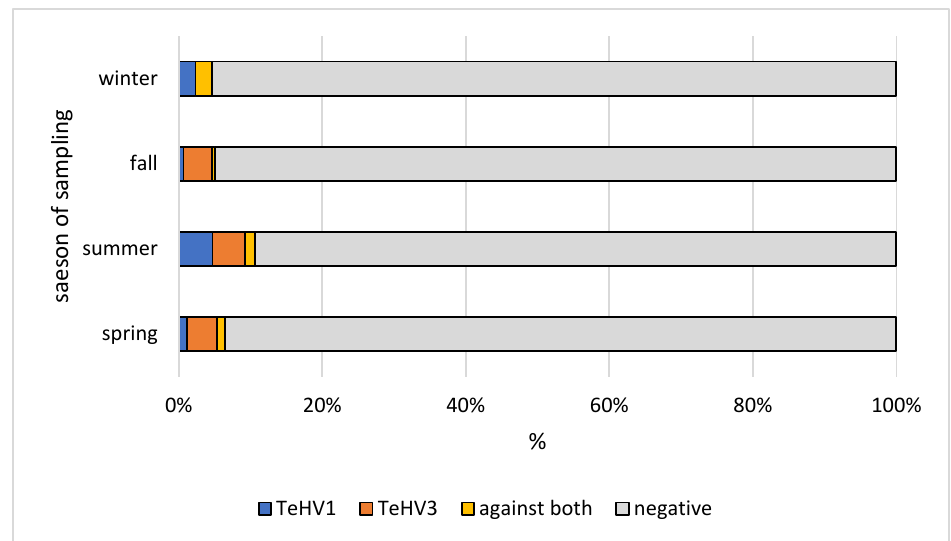
Figure 5. Herpesvirus (TeHV1 and TeHV3) antibody detection rates (titer 2 or higher) in five Testudo species (Hermann’s tortoises, Testudo hermanni ; spur-thighed tortoises, Testudo graeca ; marginated tortoises, Testudo marginata ; Russian tortoises, Testudo horsfieldii ; and Egyptian tortoises, Testudo kleinmanni ) for the different seasons of sampling.